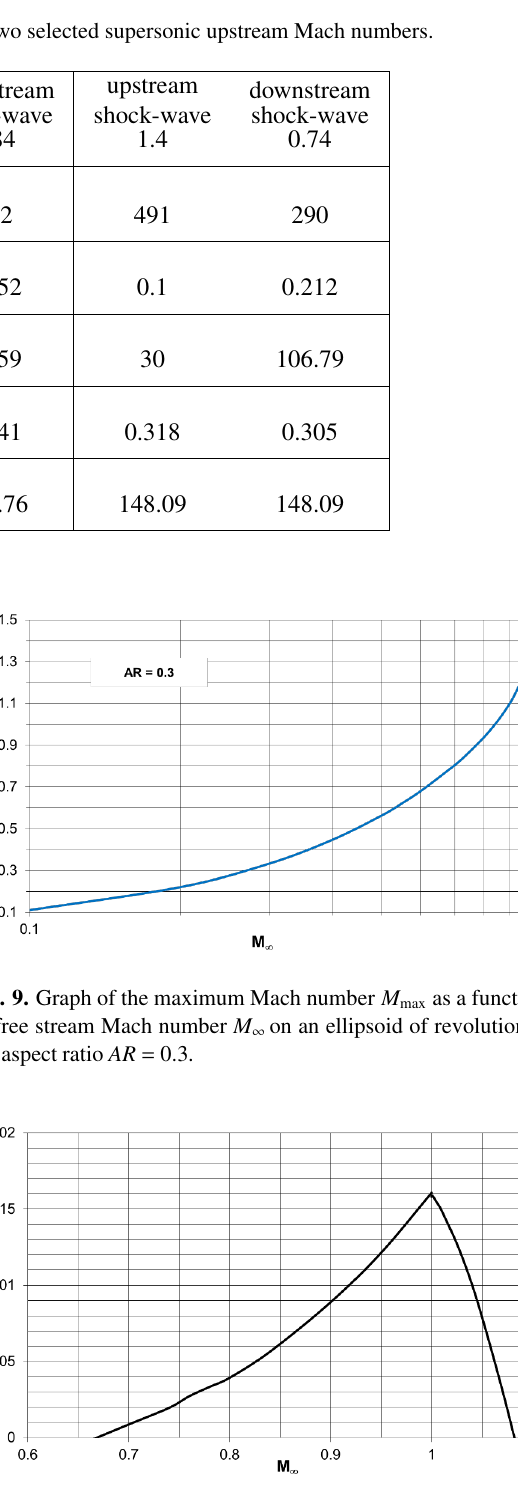
Fig. 10. Graph of the maximum possible amount of water that might condensate in the moist air x cond . as a function of free stream Mach number M ∞ for the case of the flow past an ellipsoid of revolution of the aspect ratio AR = 0 . 3